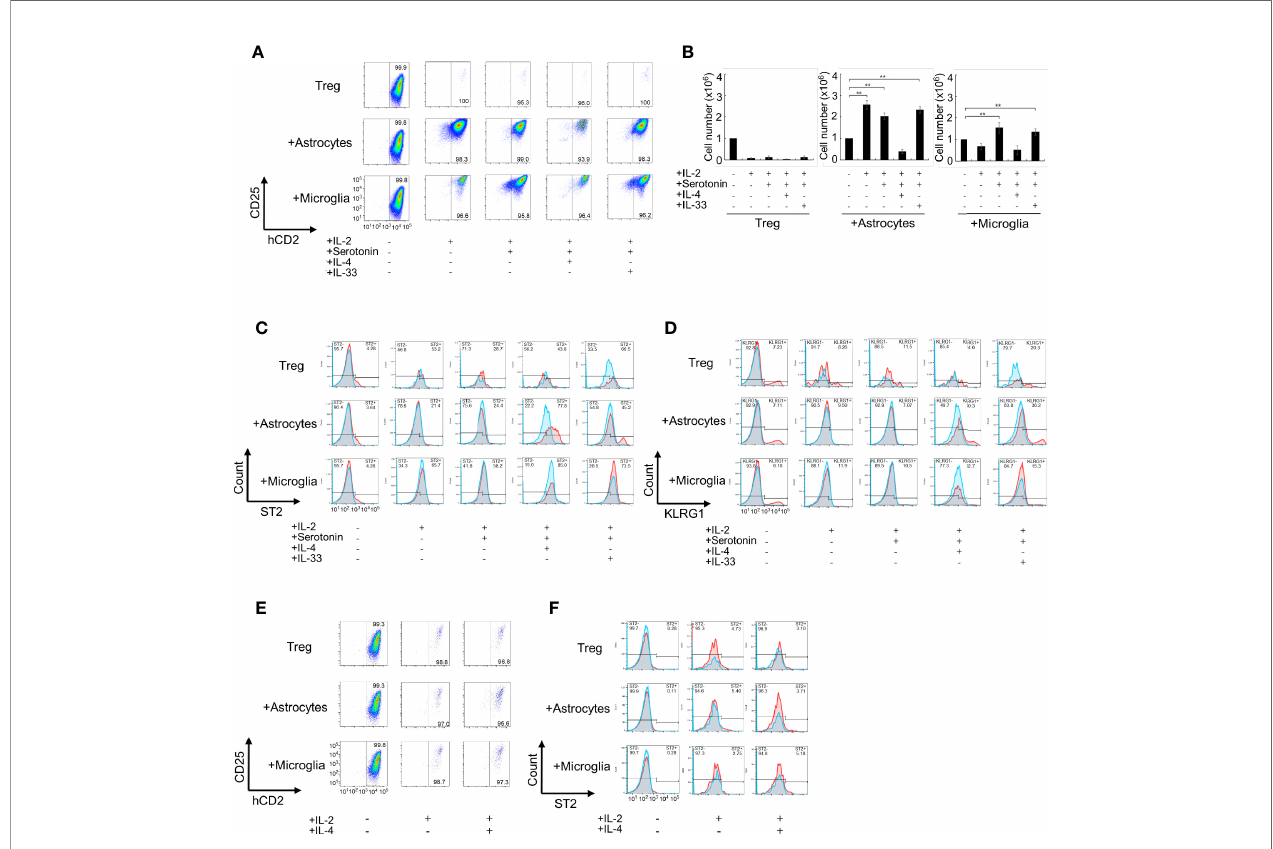
FIGURE 1 | Co-culture of Tregs with primary astrocytes and microglia in vitro. (A – D) Tregs alone or co-cultured with astrocytes or microglia in the presence of indicated cytokines (20 ng/mL) or serotonin (10 m M) in the presence of IL-2 and anti-CD3/CD28 antibodies for 6 days. The Foxp3 and CD25 expression was analyzed using FACS (A) , Foxp3 + Treg cell number was estimated (B) , and ST2 and KLRG1 expression was analyzed using FACS (C, D) . The left panels [all cytokines and serotonin are (-)] are shown as before co-culture. (E, F) Effect of transwell on the activation (E) and ST2 expression (F) of Treg under co-culture with astrocytes. In (C, D, F) , Blue fi nes were without fi rst antibody, Red lines were with fi rst antibody, and overlapping regions were shown in gray. * P<0.05 **